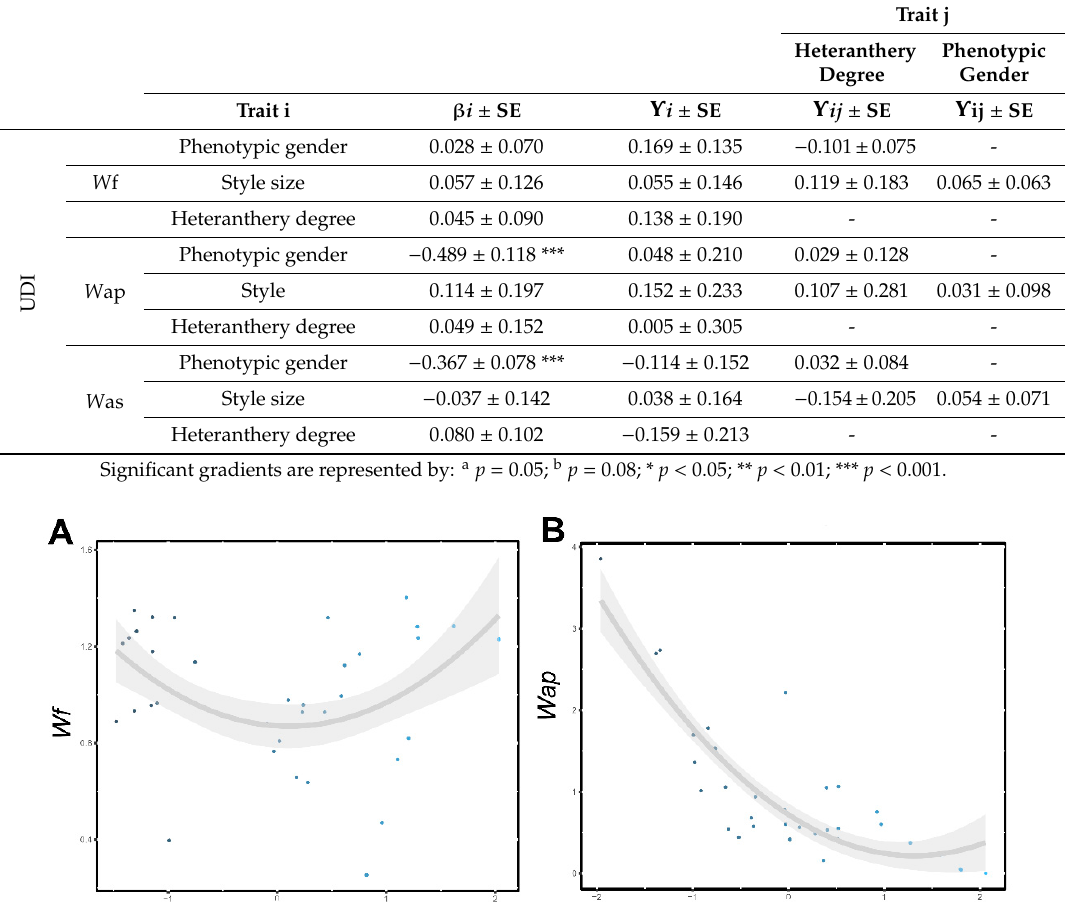
Table 2. Standardized selection gradients (directional, β i ; quadratic, γ ij and correlational, γ ij ) for floral traits and their correlation in Macairea radula through the female ( w f) and male ( w ap—antepetalous stamens—and w as—antesepalous stamens–) fitness components in the two studied populations.